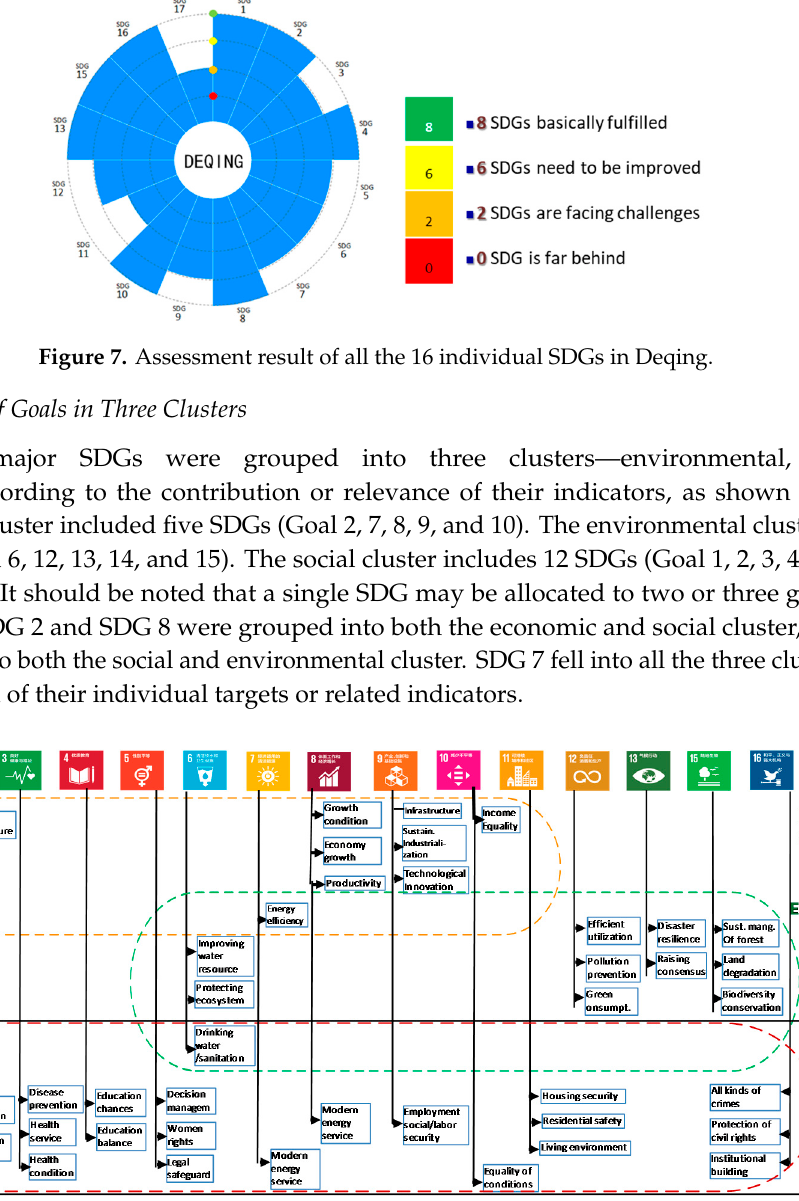
Figure 8. Three goal clusters and their affiliated targets.